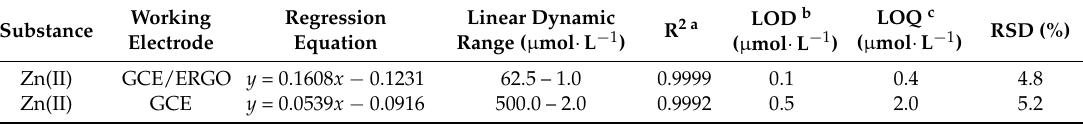
Table 1. Analytical parameters of electrochemical detection of Zn(II).